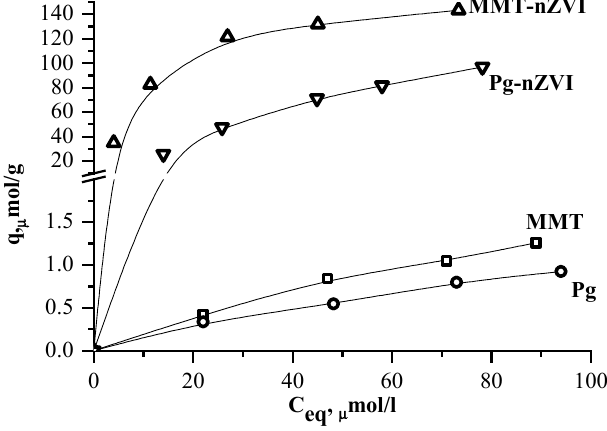
Figure 11. Sorption isotherms of U(VI) ions on pristine and nZVI-modified montmorillonite and palygorskite from mineralized waters.